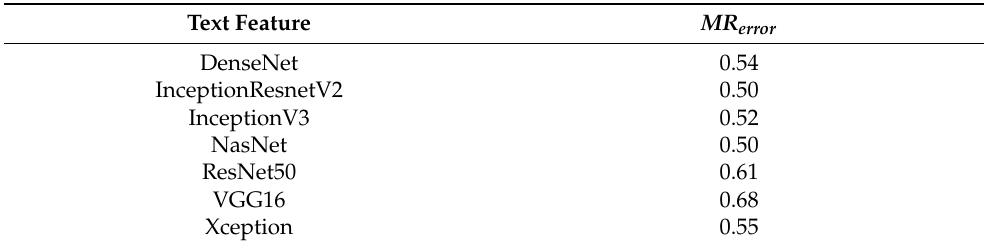
Table 9. MR error for each image feature.